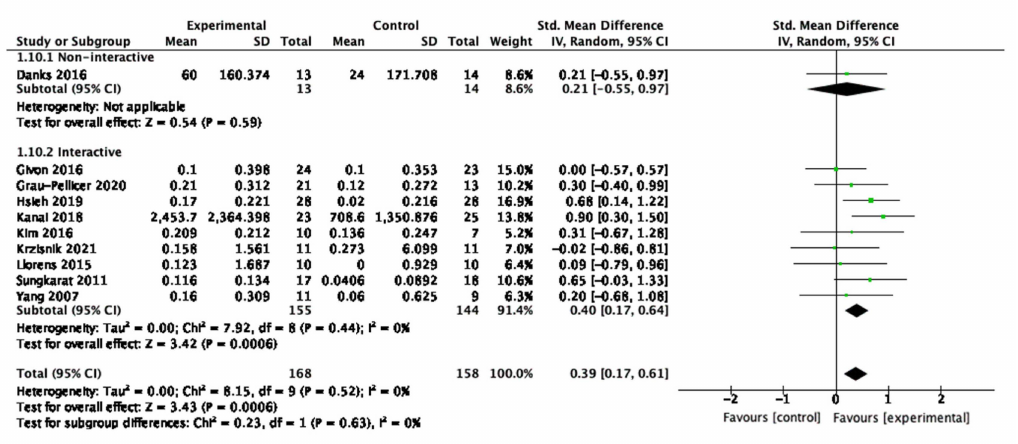
Figure 11. Subgroup analysis for participant interactivity with the digital interventions that measured physical behaviour